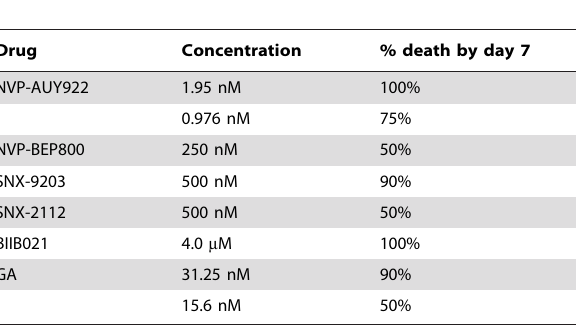
Table 3. Minimal effective doses of various compounds on Mf viability.